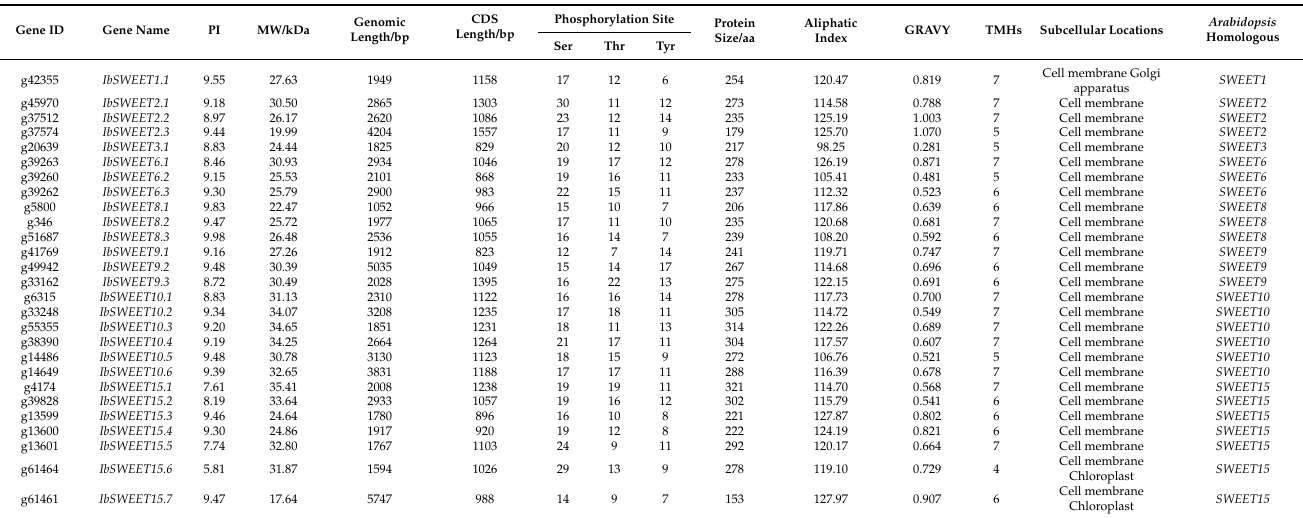
Table 1. Characterization of IbSWEETs in sweet